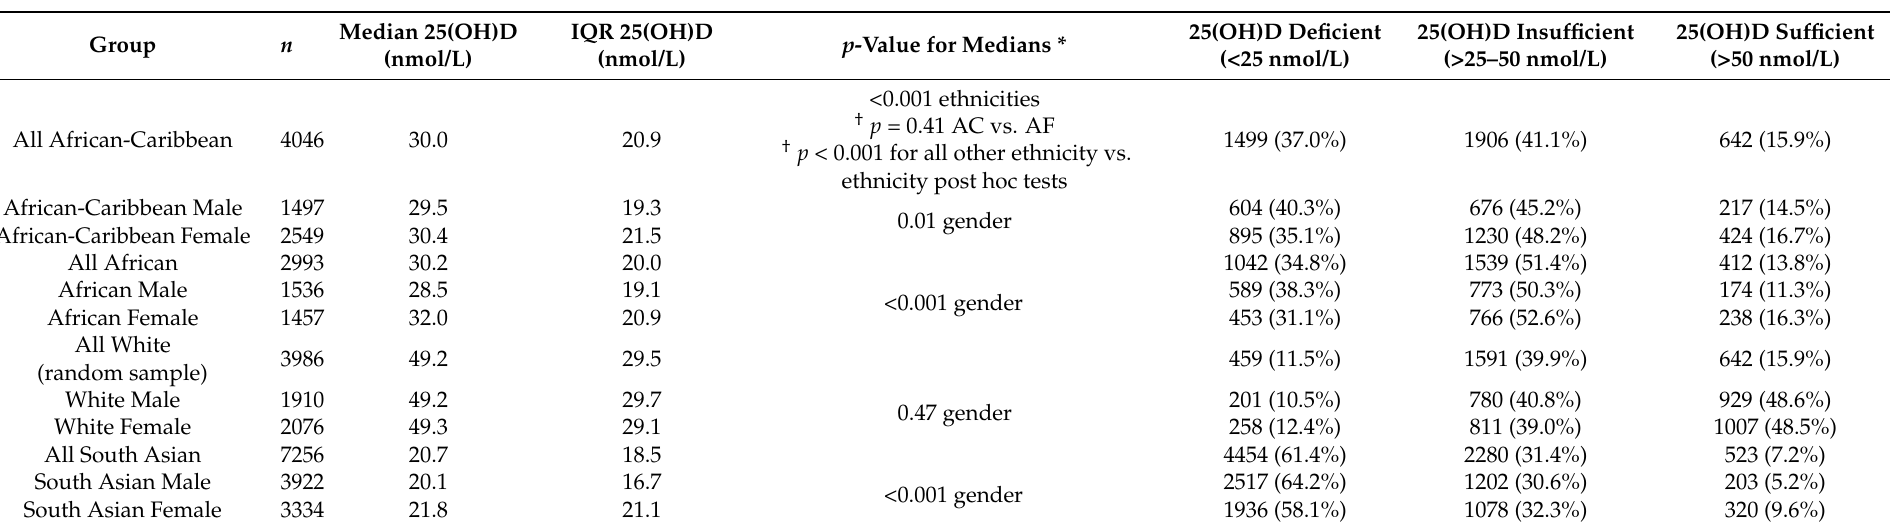
Table 2. Median 25(OH)D concentration and vitamin D cut-offs of the African-Caribbean ( n = 4046), African ( n = 2993), White ( n = 3986) and South Asian ( n = 7256) participants from the UK